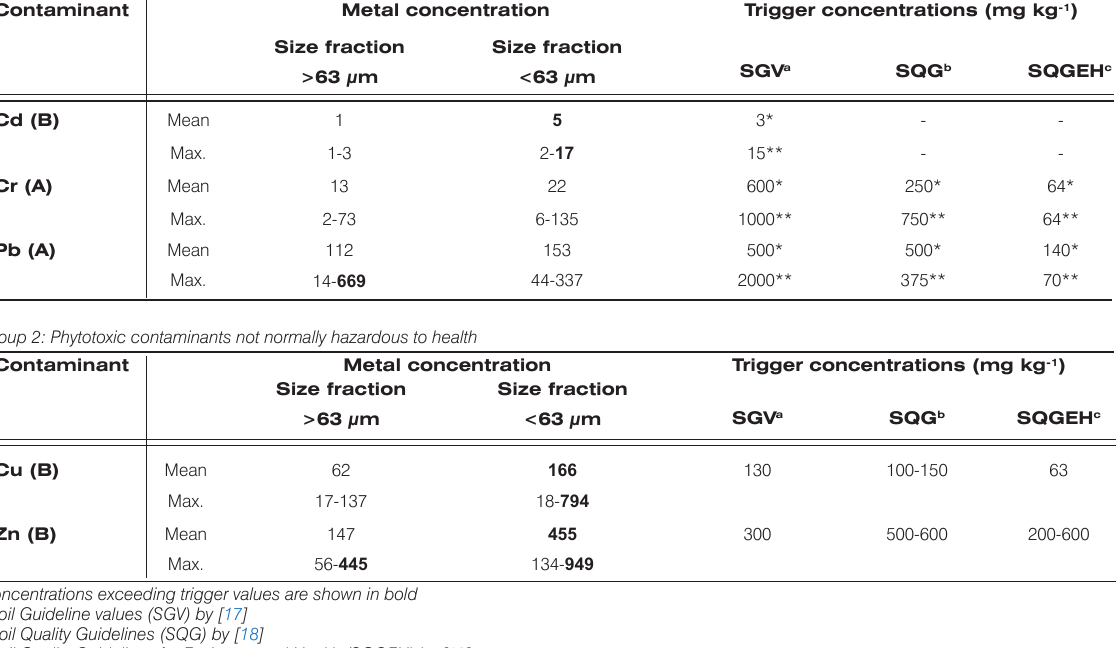
Table 4. Comparison of observed metal concentrations with published guide line values: (A) near curb; (B) 1 m from the curb) Group 1: Contaminants which may pose hazard to health